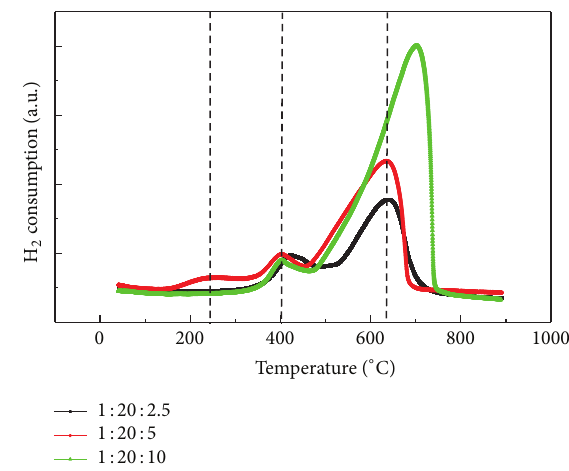
Figure 10: H 2 -TPR profiles over In/HZSM-5/In 2 O 3 catalysts with different In:HZSM-5 :In 2 O 3 weight ratios.